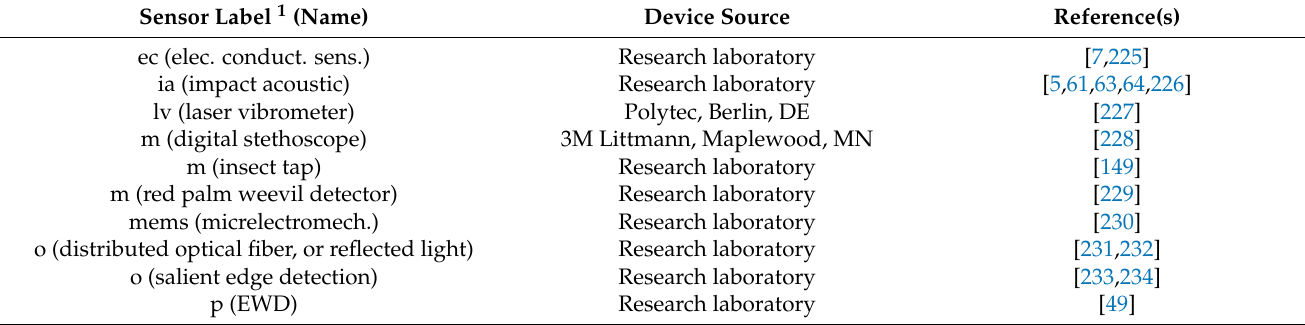
Table 4. Recently developed sensor systems applicable to pest insect detection in stored